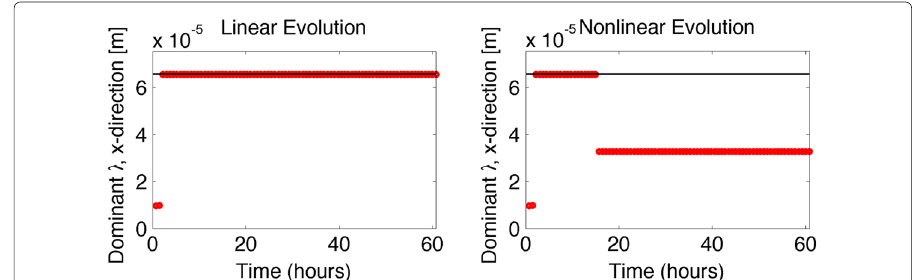
Fig. 13 Convergence of the dominant wavelength in the x-direction both linear evolution ( left ) and nonlinear evolution ( right ). Blackhorizontalline indicates analytical result. The nonlinear result shows that initially the morphology reaches a steady solution near the analytical result, but as time advances the nonlinear term takes over and the solution converges at this